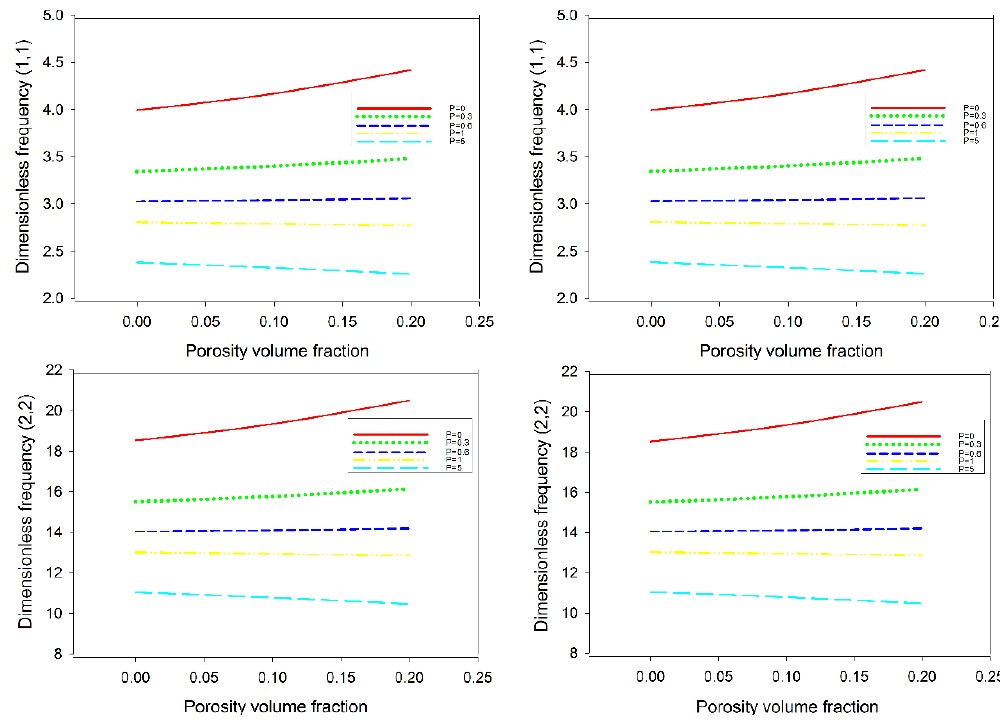
Figure 4. Dimensionless frequency of FG porous spherical shell against different power ‐ law indices and porosity volume fractions distributions: ( a ) FGM ‐ type 1; ( b ) FGM ‐ type 2. Appl. Sci. 2017 , 7 , 1252